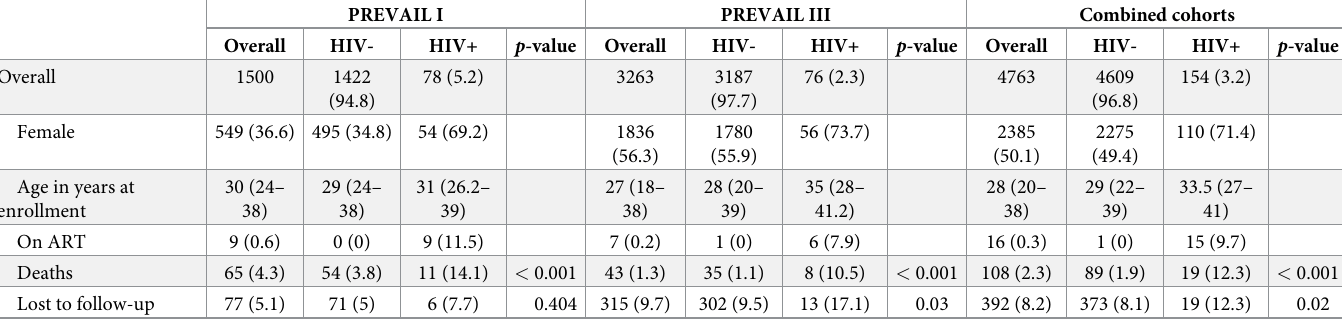
Table 1. Summary of characteristics, as well as number of deaths and number lost to follow-up, between HIV-positive and HIV-negative participants at PREVAIL I and PREVAIL III baseline.